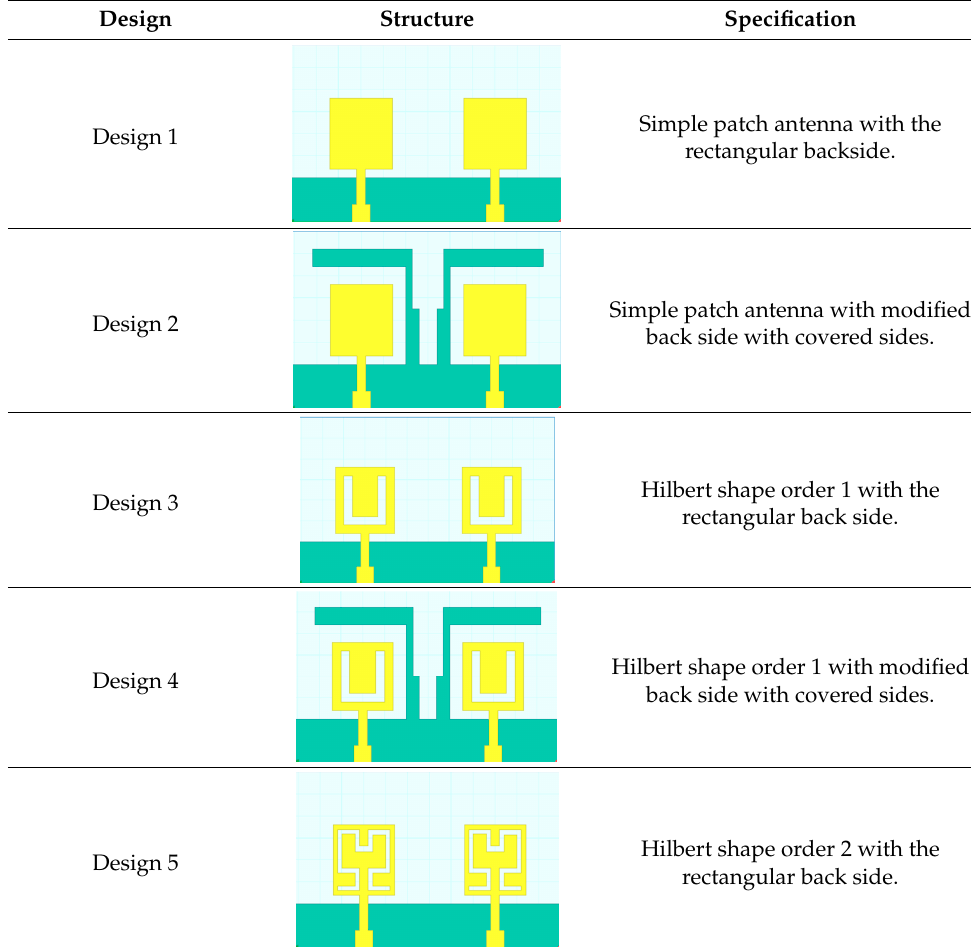
Figure 1. Schematic view of the Hilbert patch-shaped MIMO antenna. ( a ) A view of the antenna in three dimensions, and ( b ) views of the antenna from the top and bottom. Table 1. Dimensions of the antenna (in µm). Dimensions L Table 2. Different antenna designs and their specifications .